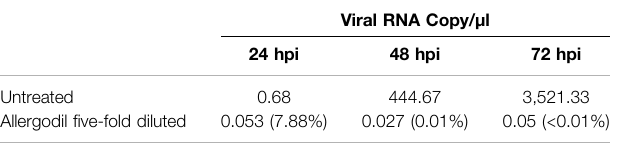
TABLE 2 | Viral RNA copy numbers in untreated and azelastine-treated nasal